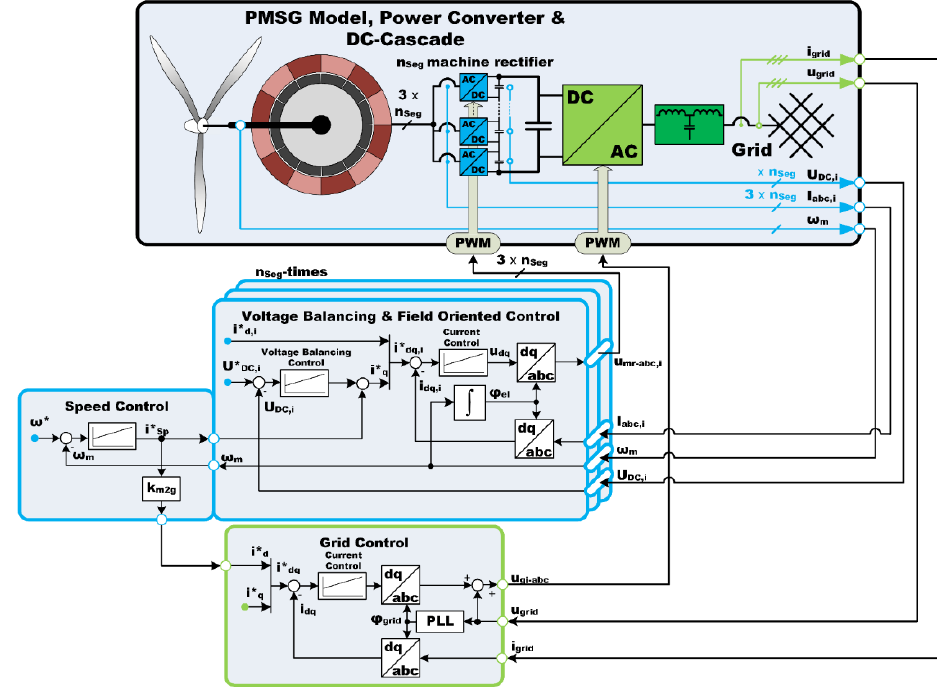
Figure 3. Extended Control of the PMSG with DC-cascade balancing